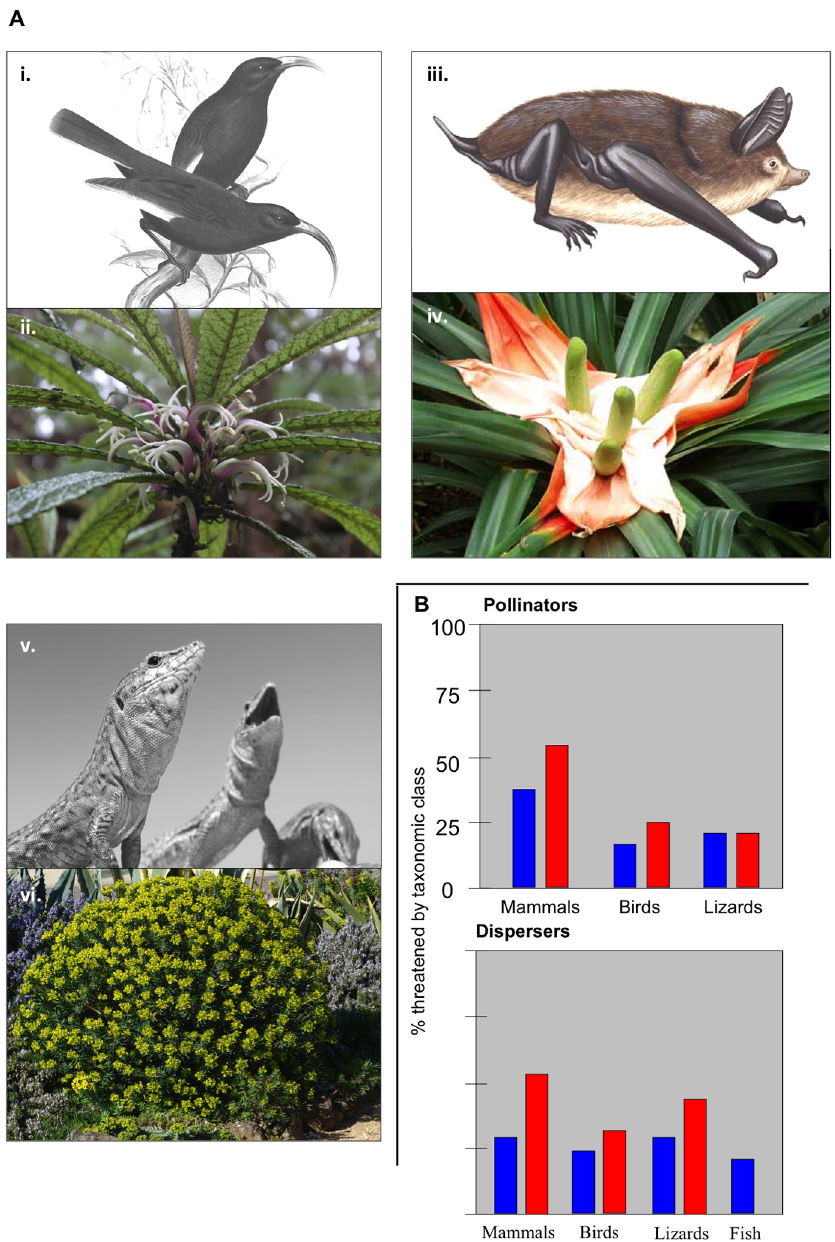
Figure 4. Existing widow plants demonstrate reduced reproduction, while threatened vertebrates suggest that many more species may become widowed, especially on islands. a ) The extinction of honeycreepers including (i) Hawaii’s black mamo ( Drepanis funerea ) resulted in widowhood for lobelioids including (ii) Cyanea stictophylla [29]. The near extinction of (iii) New Zealand’s greater short-tailed bat ( Mystacina robusta ) widowed (iv) Freycinetia baueriana [30]. The island-scale extinction of (v) the lizard Podarcis lilfordi in the Balearic Islands disrupted the pollination of (vi) Euphorbia dendroides [31]. b ) IUCN conservation status rankings for vertebrate pollinators and dispersers reveal that island endemic species (red bars) are more vulnerable by percent threatened than are vertebrate mutualists globally (green bars). Photo/image credits: F. W. Frowahk ( Drepanis funerea ); C. Aslan ( Cyanea stictophylla ); B. Duperron ( Mystacina robusta ); Armchair Travel and Kew Gardens ( Freycinetia baueriana ); D. Andre´ ( Podarcis lilfordi ); K. Kozminski ( Euphorbia dendroides